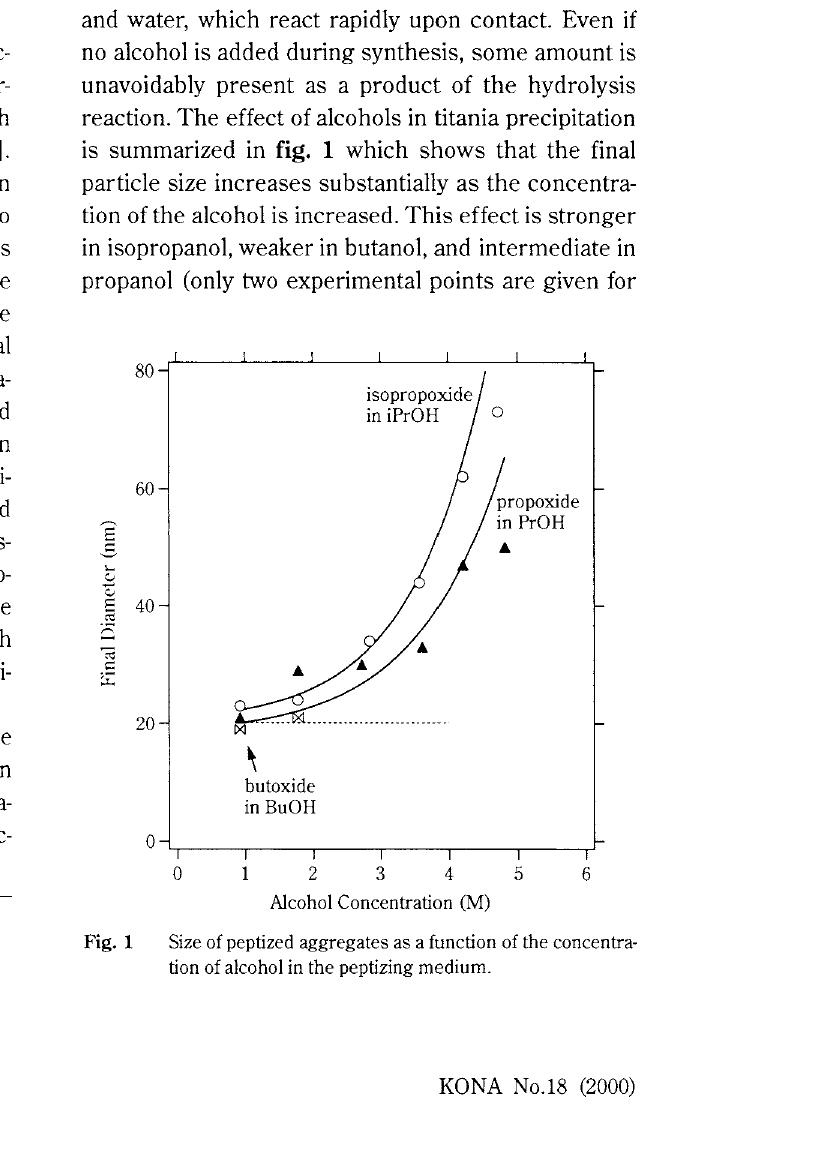
Fig. 1 Size of peptized aggregates as a function of the concentra tion of alcohol in the peptizing